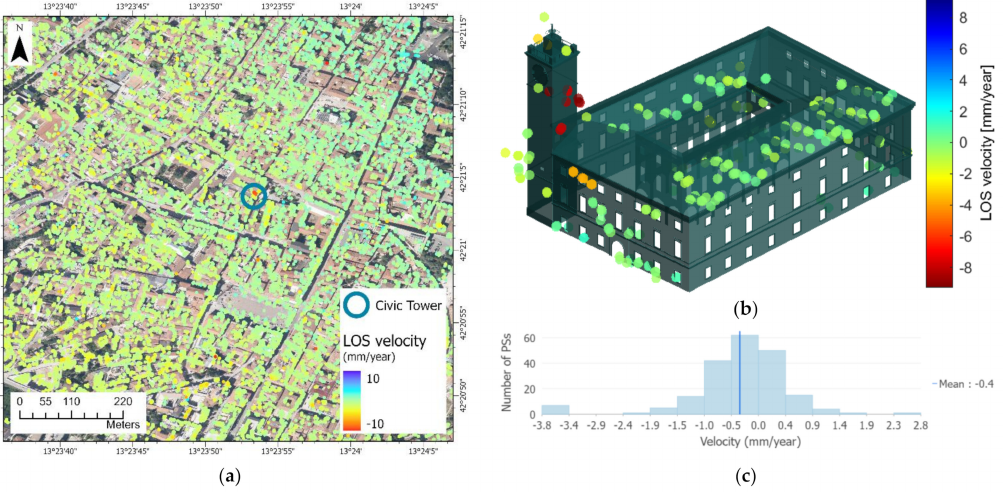
Figure 7. Overview of the LOS velocity (mm/year) derived from the PS-InSAR analysis for the city center of L’Aquila ( a ) and both Palazzo Margherita and the Civic Tower ( b ). Negative values range from yellow to red color, positive values from cyan to blue. The frequency distribution of the PSs over Palazzo Margherita, excluding the Civic Tower, is shown in ( c